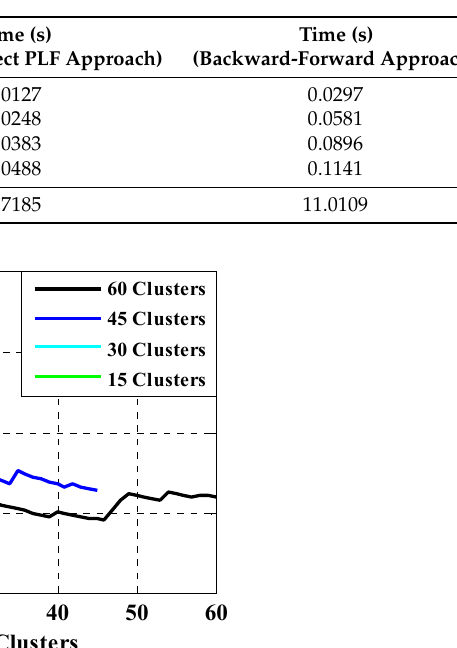
Table 6. Calculation run-time results for proposed method, based on both simple MCS and data clustering (69-bus system).